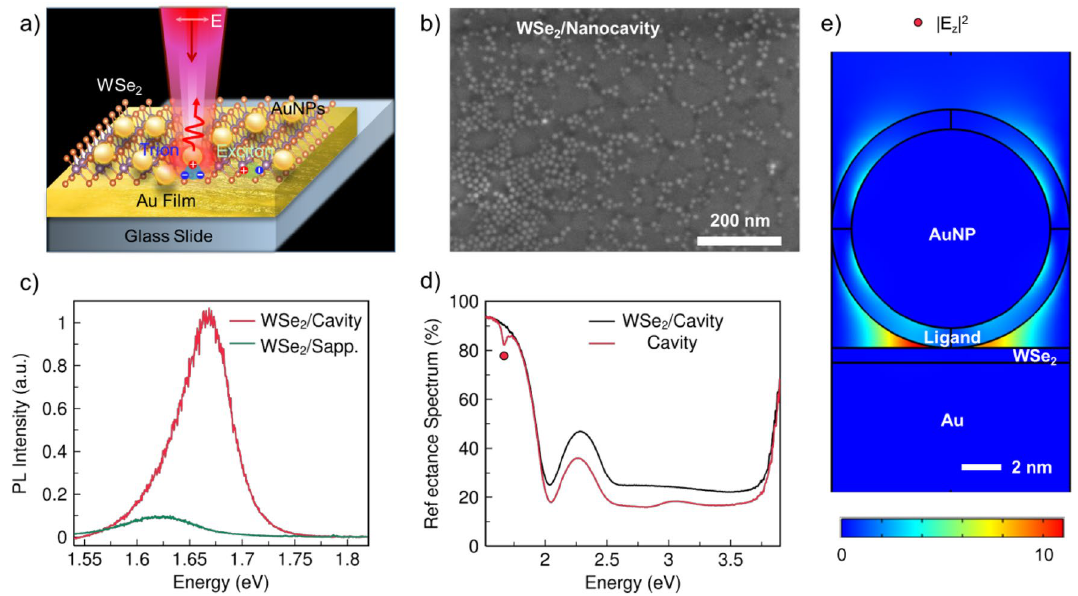
Figure 1. Monolayer WSe 2 embedded in a plasmonic nanocavity and characterizations. ( a ) Schematic of monolayer WSe 2 embedded in a plasmonic nanocavity comprising gold nanoparticles (AuNPs) and gold-film substrate, with enhanced PL emission being observed. ( b ) Representative scanning electron microscope (SEM) image of monolayer WSe 2 embedded in nanocavity (WSe 2 /Nanocavity). ( c ) PL spectra of monolayer WSe 2 in nanocavity and monolayer WSe 2 on sapphire with an emission peak at 1.67 eV and 1.62 eV, respectively. ( d ) Reflectance spectra of nanocavity with and without monolayer WSe 2 . The red dot at 1.68 eV denotes the energy of localized plasmon resonance. ( e ) Finite-difference time-domain (FDTD) simulation of the enhanced electric displacement intensity, | E z | 2 , inside the monolayer WSe 2 due to the localized vertical gap